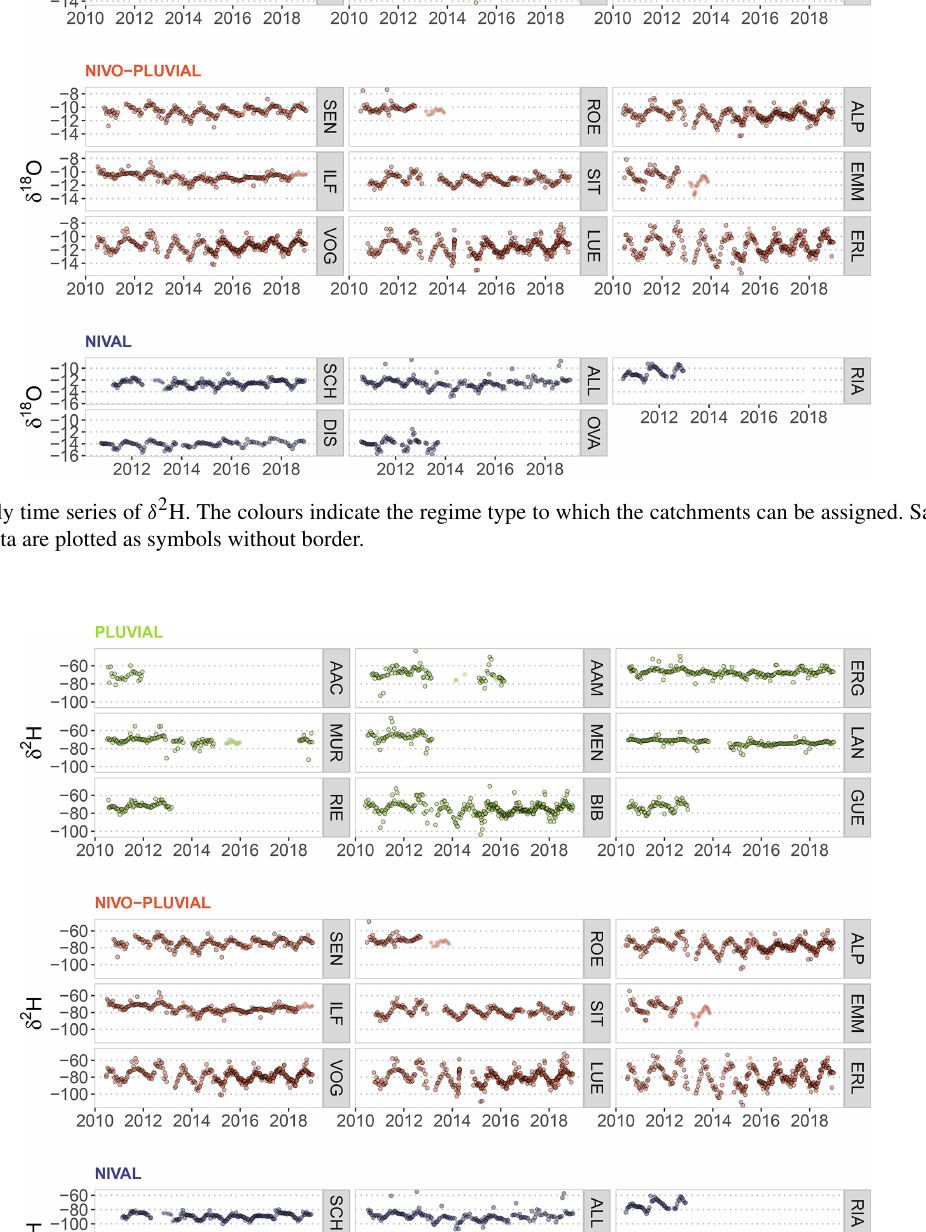
Earth Syst. Sci. Data, 12, 3057–3066,